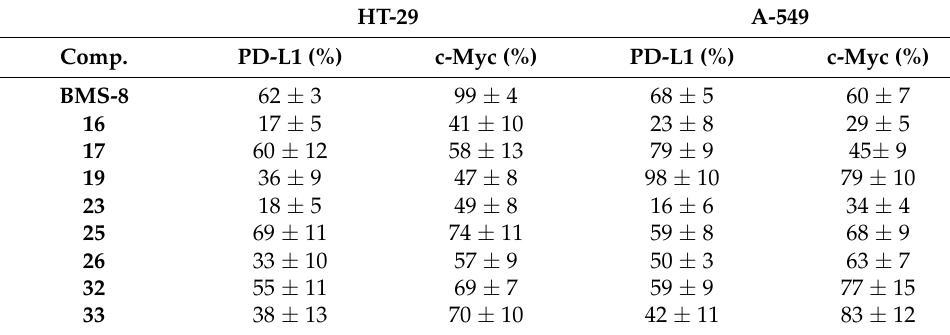
Table 4. PD-L1 and c-Myc protein relative expression on HT-29 and A-549 cell lines.